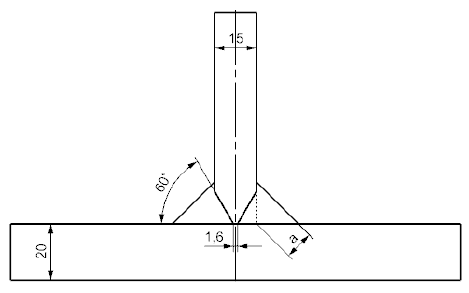
Figure 3. T-joint geometry.